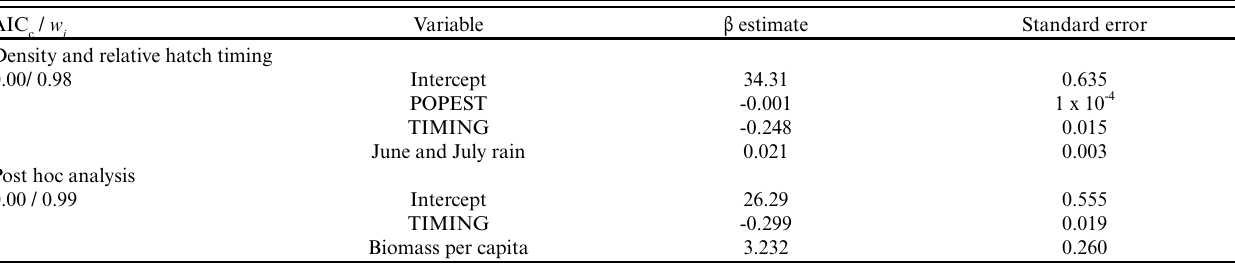
included the variables relative timing of hatch, rainfall, and biomass per capita, included an uninformative relationship for the rainfall variable (Appendix 1). We dropped the rainfall variable and ran a reduced model, which was the most parsimonious, and included only the variables relative timing of hatch and biomass per capita (Table 2). The relationship between gosling size and relative timing was similar to the analysis above though the relationship with biomass per capita was positive (Fig. 5). Fig. 4 . The relationship between the annual individual gosling size (depicted as the annual means for clarity) at banding and an index of population density for Canada Geese on Akimiski Island, Nunavut (after controlling for the effect of hatch timing relative to forage plant phenology and total June and July rainfall). Gosling size was measured from 1993-2010, and population abundance is an index derived from annual aerial surveys for the same period. Bars are 95% confidence limits.